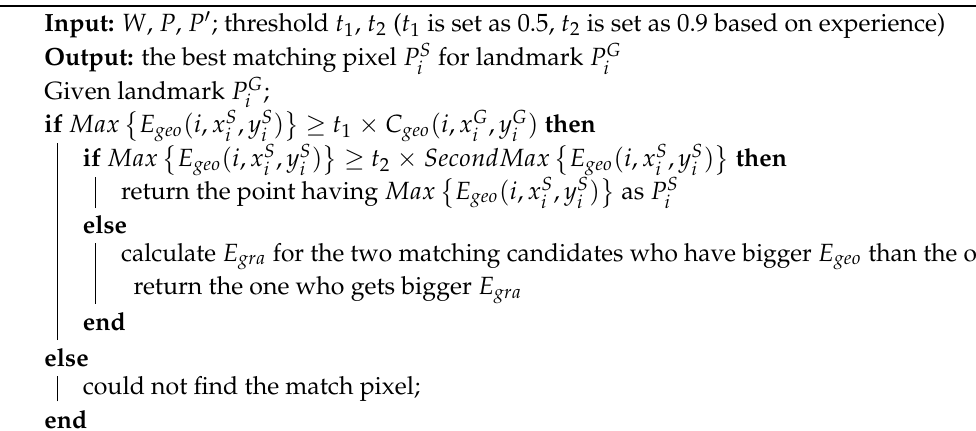
Algorithm 1: Local feature